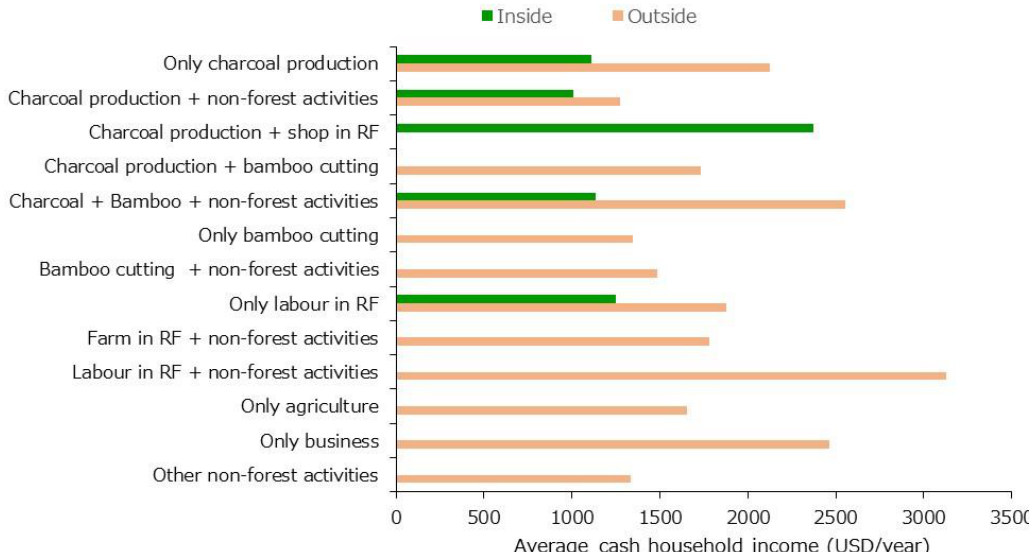
Figure 2. Share of different cash income strategies among all the sample households (% of outside- and inside-households).